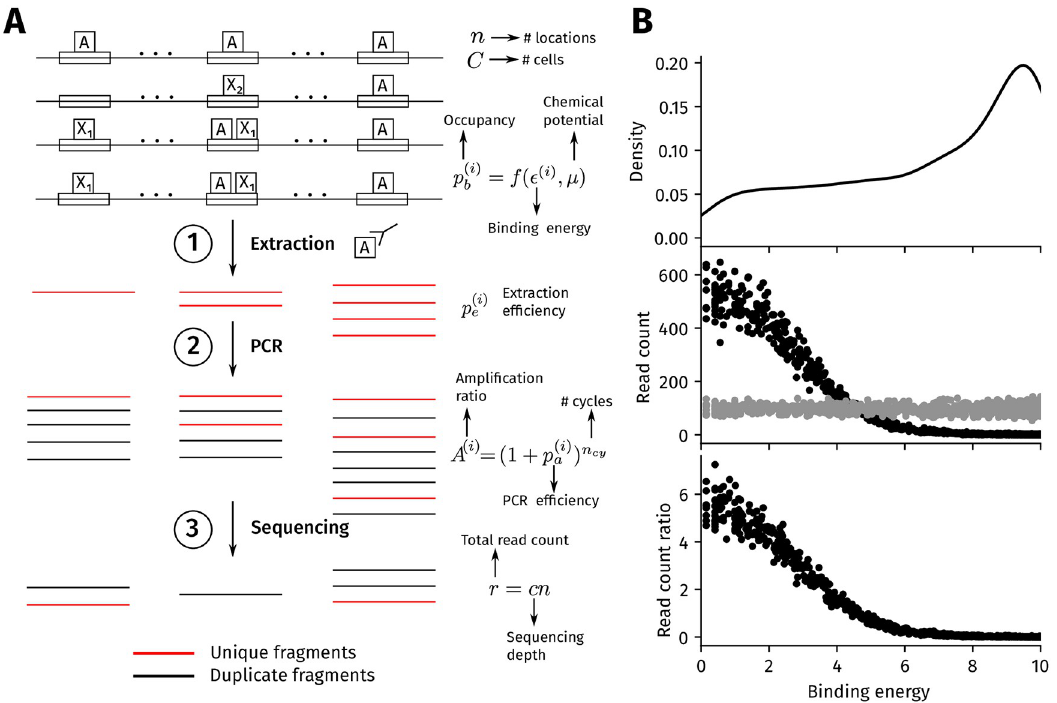
Fig 1. ChIP-seq simulation procedure. (A) Procedure overview. Each of n genomic regions contains a binding site with a binding energy � ( i ) (in units of k ), where a lower value represents a higher affinity binding site. In the ChIP sample, the binding energy at B T ) of the target TF. The probability of occupancy the i-th location, and the chemical potential, set the probability of occupancy ( p ð i Þ b determines the number of cells (out of a total of C cells) where the i-th location is bound. In Step 1 of the simulation, a total of F ð i Þ e fragments are extracted at the i-th location from a binomial distribution with mean Cp ð i Þ . p ð i Þ is the extraction efficiency that e e represents the probability of successfully extracting a bound fragment. All of these fragments are unique (in red) since each fragment originates from a different cell. In Step 2, the extracted fragments are amplified through n cy cycles of PCR to give F ð i Þ amplified a fragments (duplicate fragments in black) with the probability of amplification of each fragment, or PCR efficiency, being p ð i Þ in every a cycle. The average number of amplified fragments A obtained from each extracted fragment is A ¼ ð 1 þ p ð i Þ Þ n cy , which we refer to as P a n the amplification ratio. In Step 3, r reads are obtained from the i-th location after sampling r = cn fragments from all F ð i Þ i i ¼ 1 a amplified fragments, where r is the total read count and c is the sequencing depth. The number of unique reads at each location is the final output of the simulation. For the control input sample, read counts are simulated as for the foreground ChIP sample, except that the probability of occupancy is assumed to be constant at all n locations and the number of cells is assumed to be 0.1 C . (B) Sample output from the simulation. The top panel shows the distribution of binding energies employed in the simulation, which by default is a truncated power law between 0 and 10 k with an exponent of 0.5. The middle panel shows the number of unique reads B T from each genomic region in the ChIP (black) and input (gray) experiments. The bottom panel is the read count ratio between the ChIP and input samples at each location. The simulation parameters are n = 1000, μ = 3 k , � = 1 k , C = 10 5 , n = 15, and B T bg B T cy A = 1000. The extraction efficiencies in the ChIP and input samples follow a truncated normal distribution between 0 and 1, with a mean of 0.5 and standard deviation of 0.05 across the